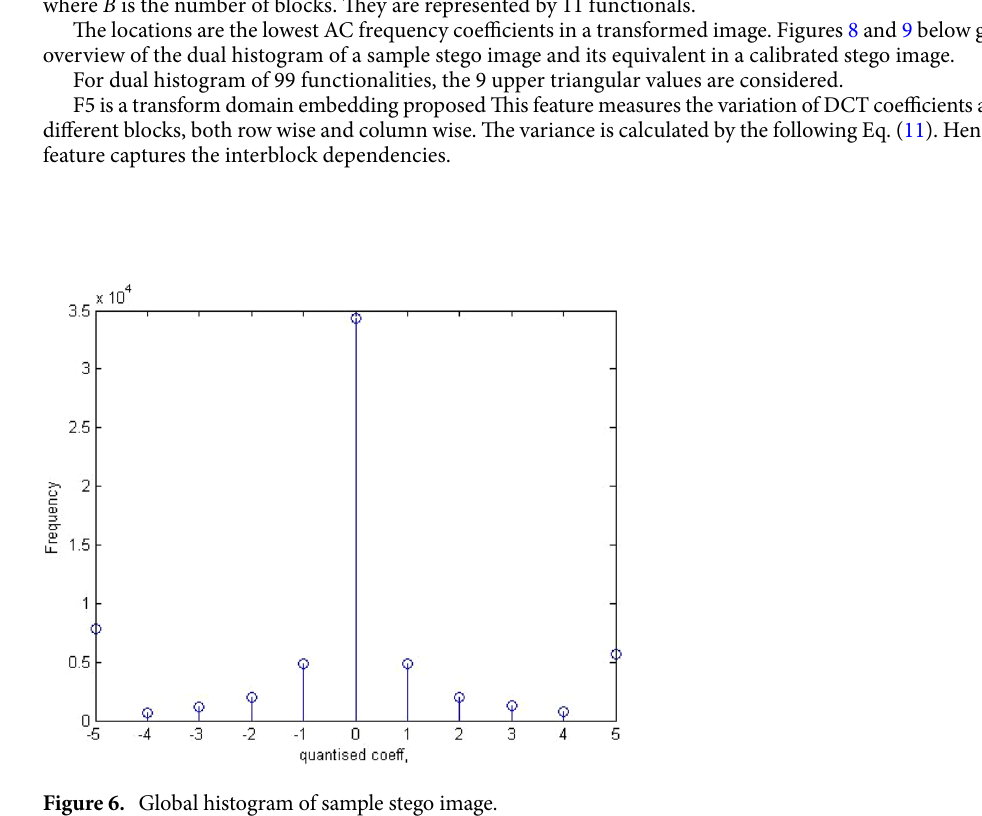
Figure 6. Global histogram of sample stego